Question: From the figure, is the trend upward or downward?
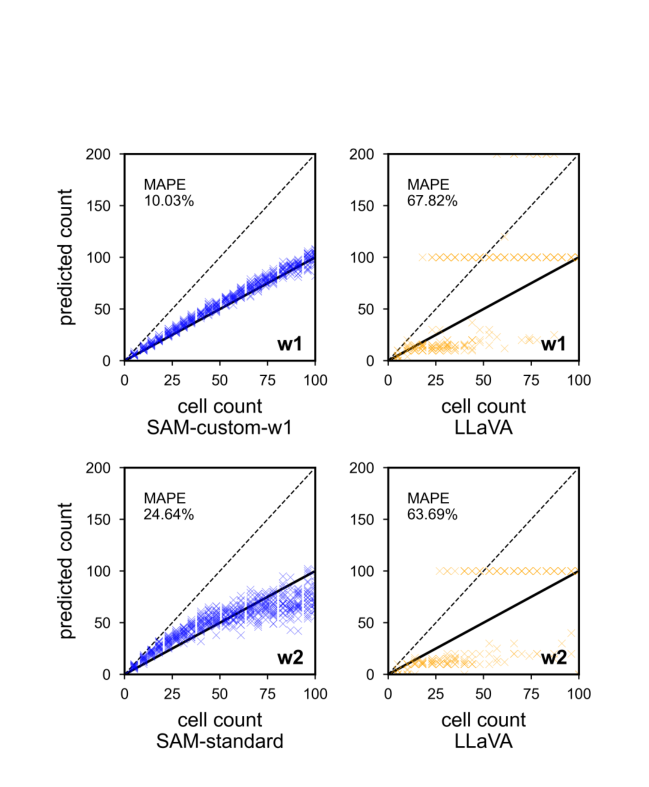
Answer: increasing